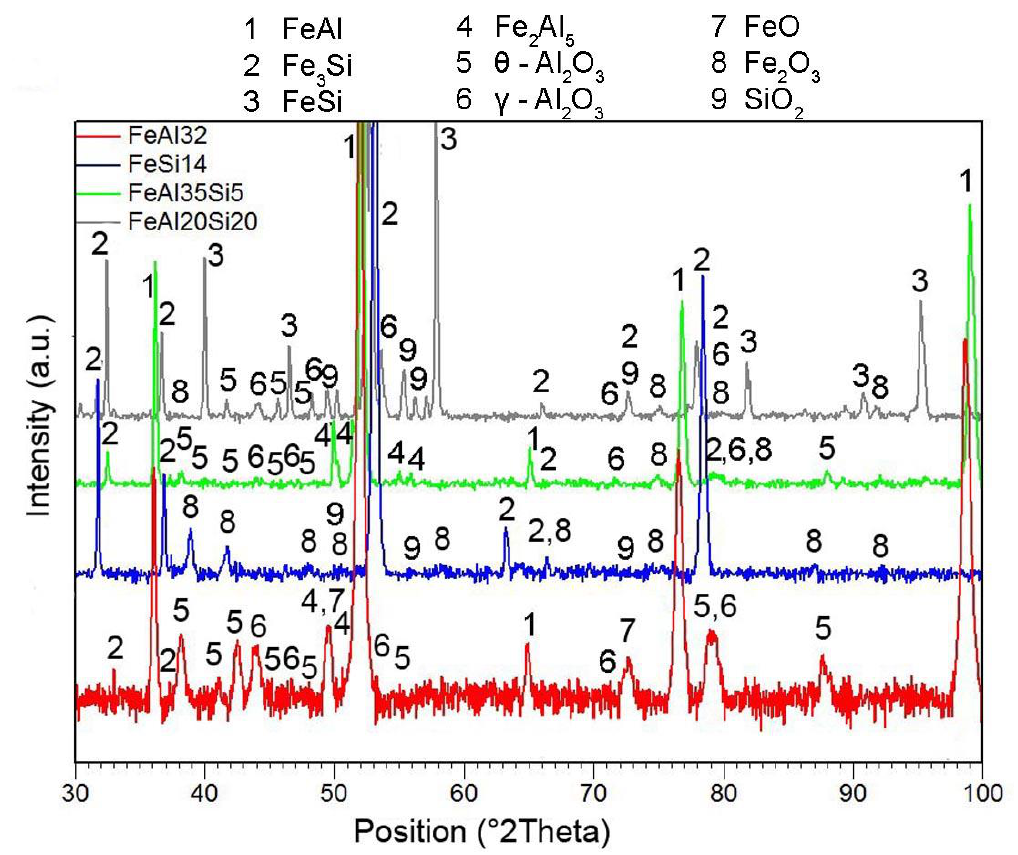
Figure 4. XRD patterns of the oxidized samples.